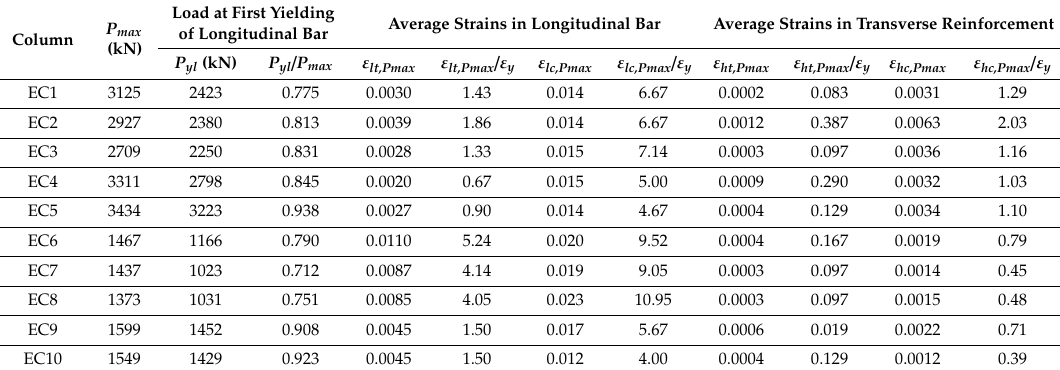
Table 3. Measured strains in longitudinal and transverse